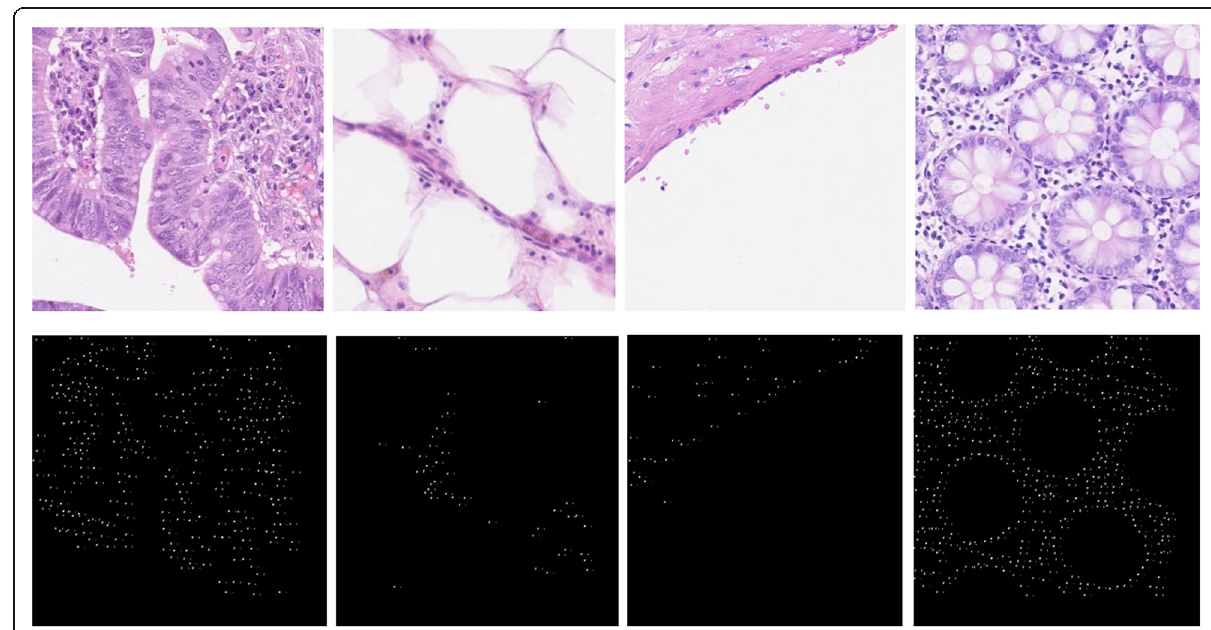
Fig. 9 Randomly selected input imagesare shown in the first row and corresponding dilated masks with 3 × 3 kernels are shown on the second row for nuclei detection tasks